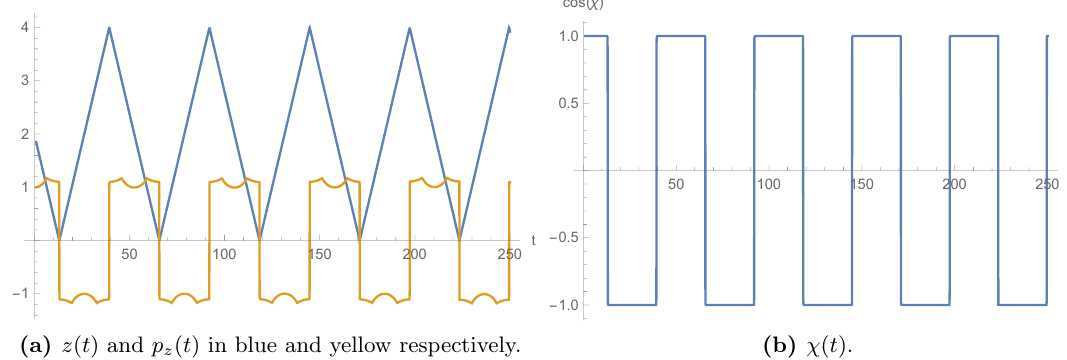
Figure 7. Numerical evolution for a string on the background solution (2.7) (quiver 3) with